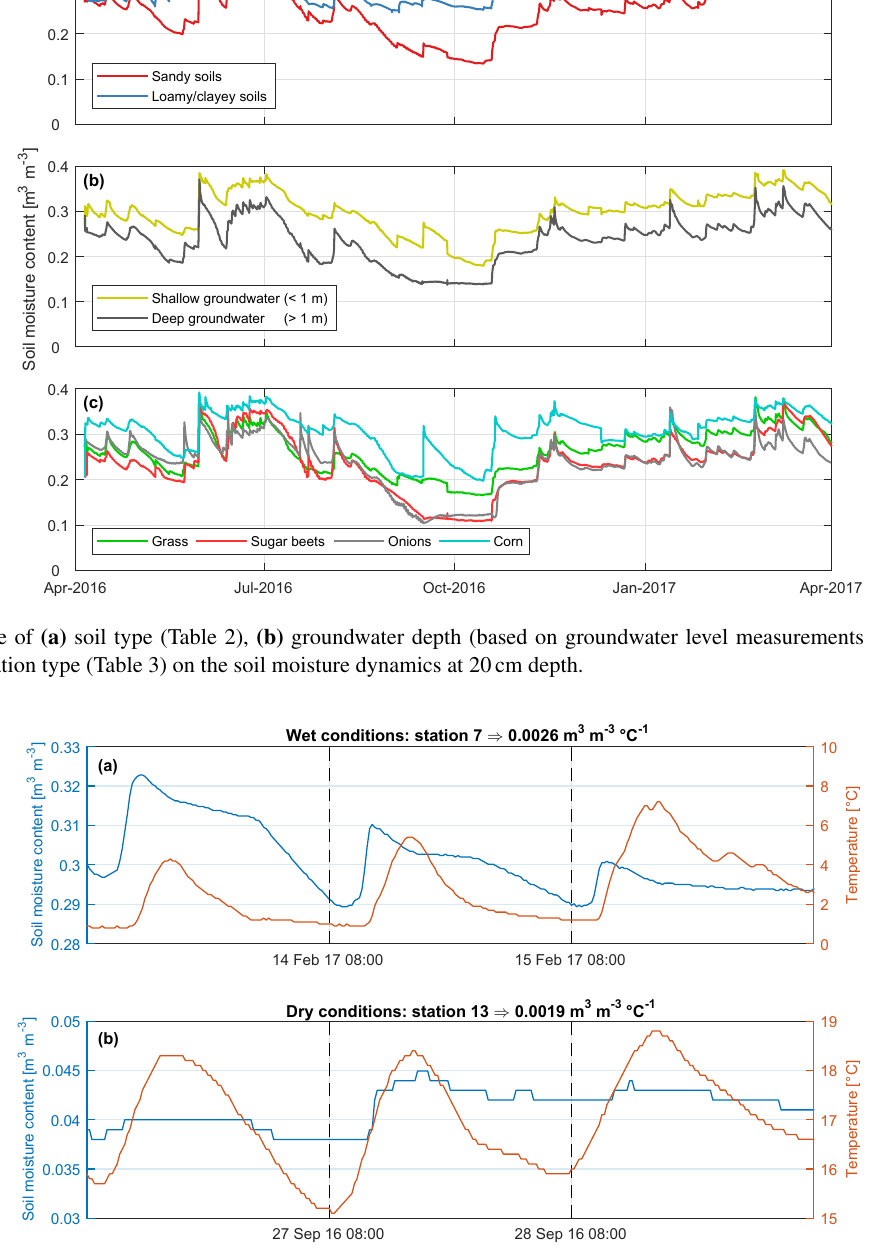
Figure 12. Largest sensitivities of soil moisture (blue line, left y axis) to temperature variation (red line, right y axis) in (a) wet conditions and (b) dry